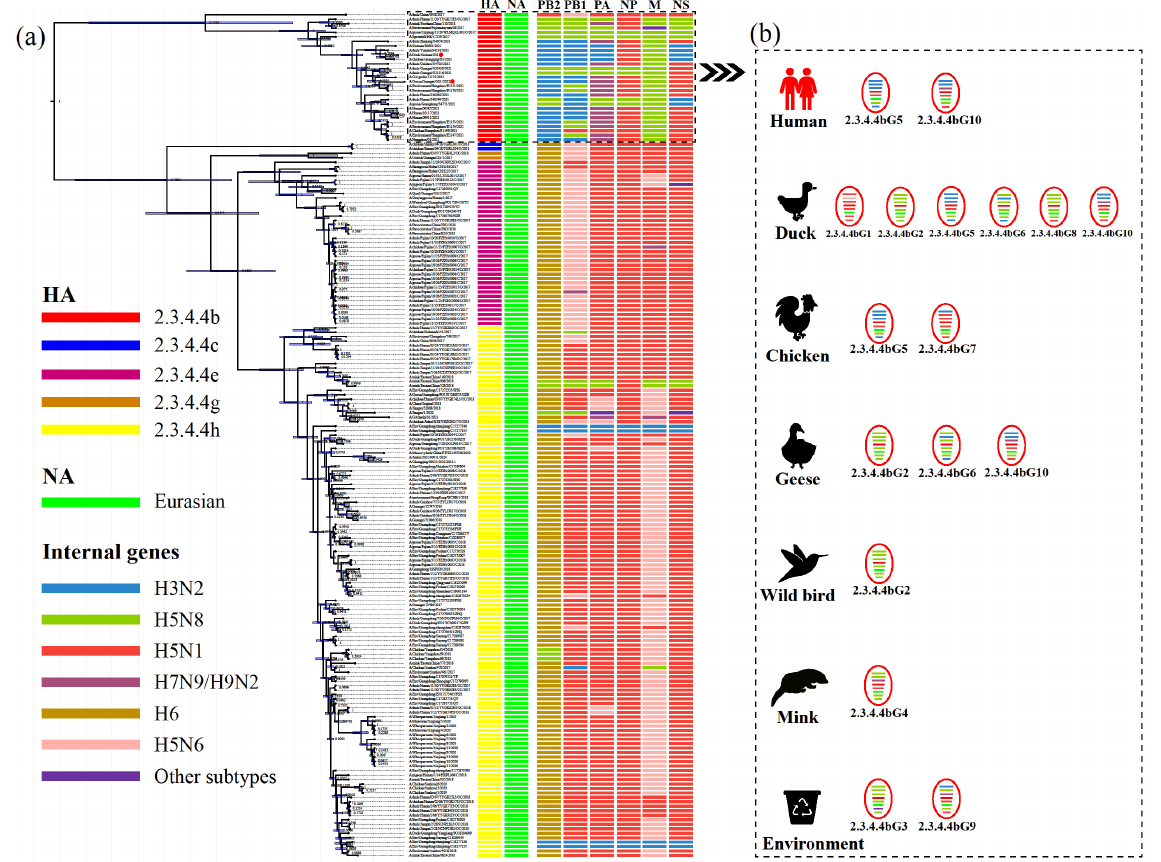
Figure 2. Molecular clock phylogenetic analysis of H5N6 AIVs in China during 2017–May 2022. ( a ) The phylogenetic tree of HA gene using BEAST (version 1.10.4) under the exponential coalescent tree prior model, “GTR+F+G4” substitution mode, and a “uncorrelated relaxed clock” model. The AIVs sequenced in this study were marked with red dots. The lineages of H5N6 AIVs genes were marked by coloured boxes. Purple node bars represented 95% credible intervals of lineage divergence times. ( b ) The genotype distribution of clade 2.3.4.4b H5N6 AIVs in different hosts. The genotypes of clade 2.3.4.4b H5N6 AIVs isolated in chickens, ducks, geese, minks, wild birds, environments, and humans . The eight segments represented by horizontal bars are, from top to bottom of the virion, PB2, PB1, PA, HA, NP, NA, M, and NS. Different colours represent different lineages. Detailed genotypes are available as the Supplementary Table S2. PB, polymerase basic protein; PA, polymerase acidic protein; HA, hemagglutinin; NP, nucleoprotein; NA, neuraminidase; M, matrix protein; NS, non-structural protein.